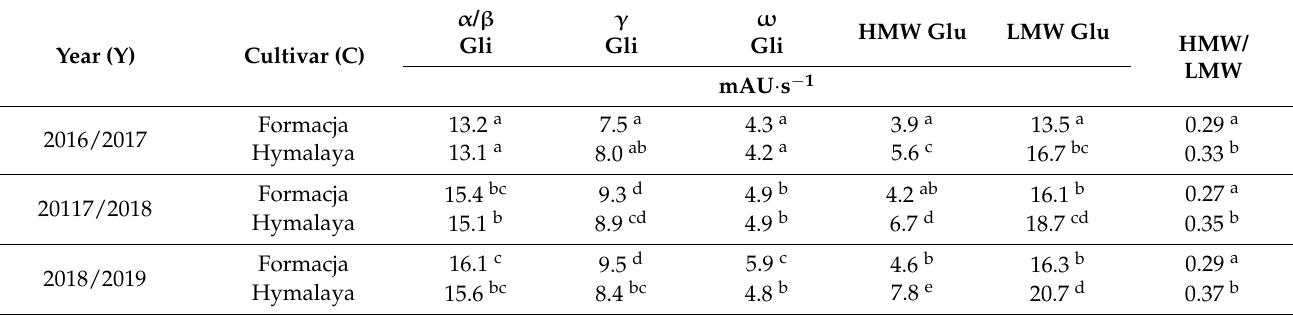
Table 7. Effect of cultivars and years of research on the protein fractions of gliadins and glutenins. α / β γ ω HMW Glu LMW Gli Gli Gli